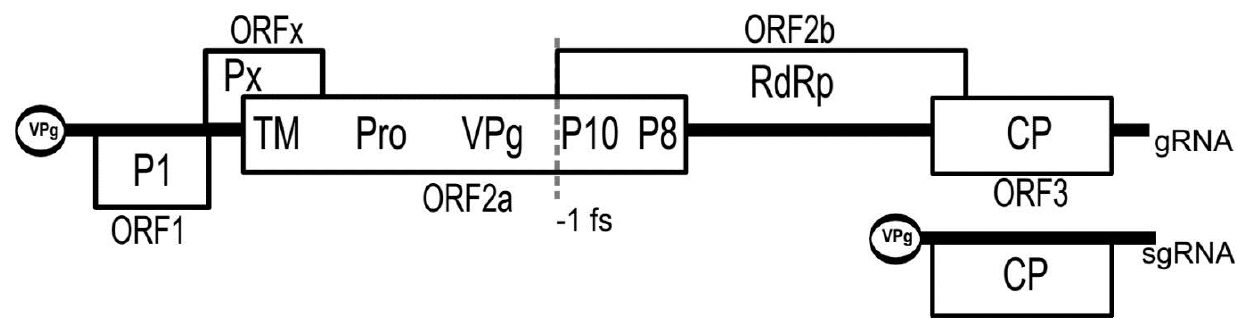
Figure 1. The genome organization of sobemoviruses exemplified by Sesbania